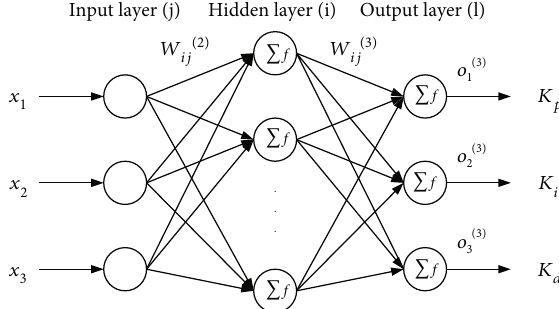
Figure 8: The diagram of BP neural network